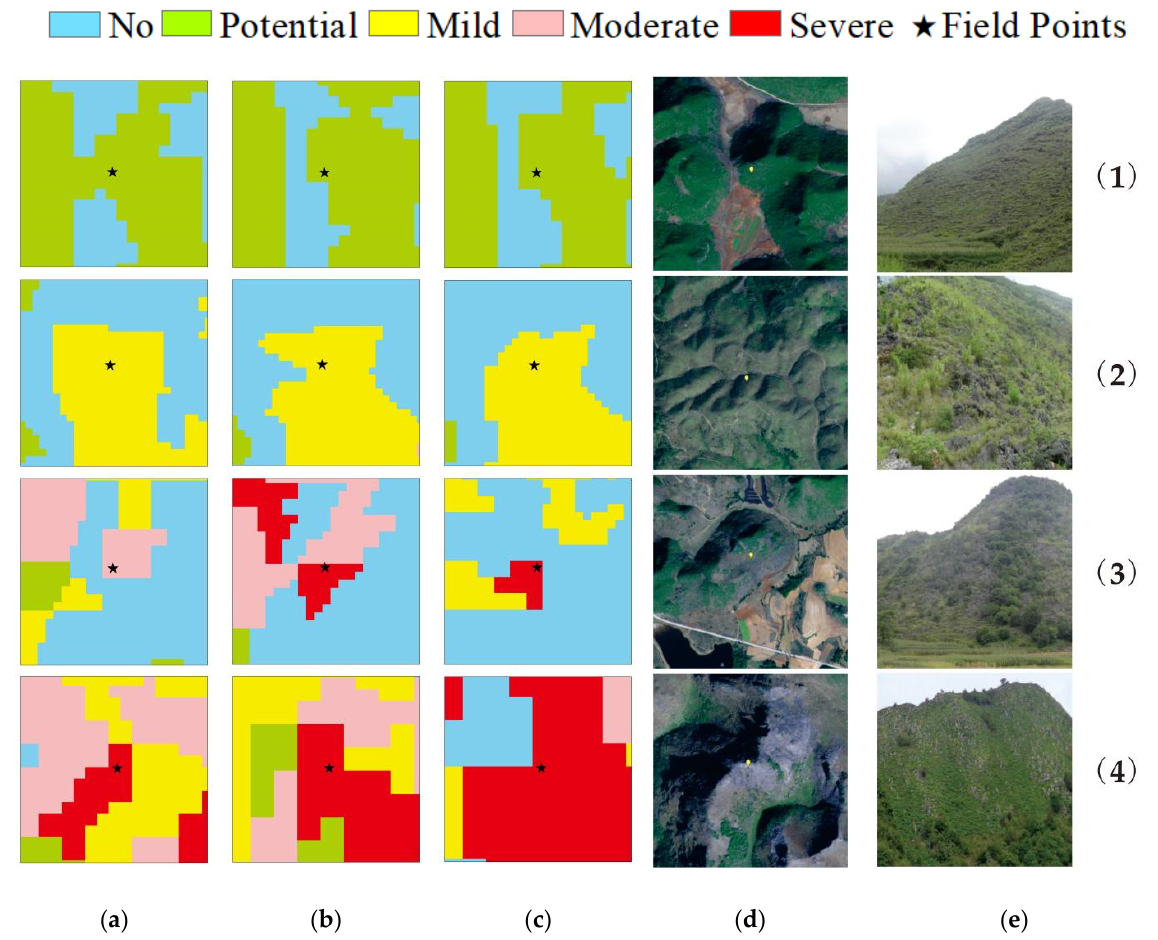
Figure 8. Comparison of classification results of rocky desertification in field sampling sites: ( a ) rocky desertification results extracted from Sentinel-2B images; ( b ) rocky desertification results extracted from Landsat-8 images; ( c ) rocky desertification results extracted from Gaofen-6 images; ( d ) Google Earth images; ( e ) field photographs: ( 1 ) potential rocky desertification; ( 2 ) mild rocky desertification; ( 3 ) moderate rocky desertification; ( 4 ) severe rocky desertification.